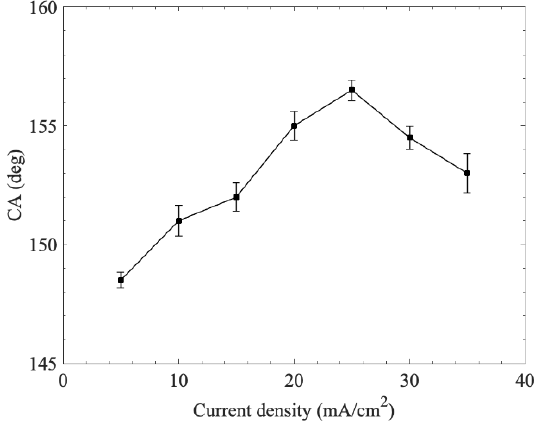
Figure 8. Effect of current density on the wettability of the copper surface.